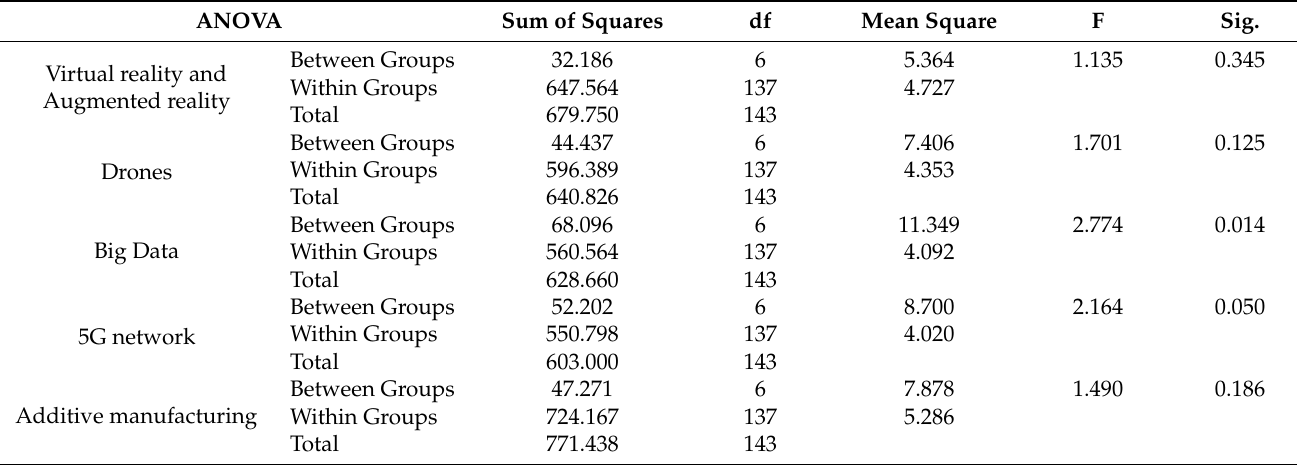
Table 9. Industry 4.0 technologies used in distribution